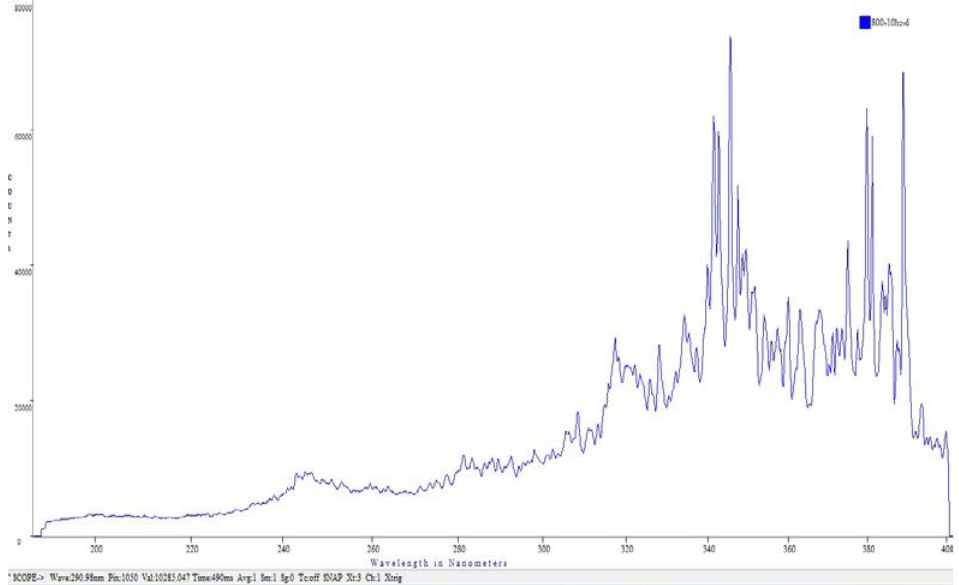
Fig.12: Emission spectra of laser energy 800 mJ with 10Hz repetition rate